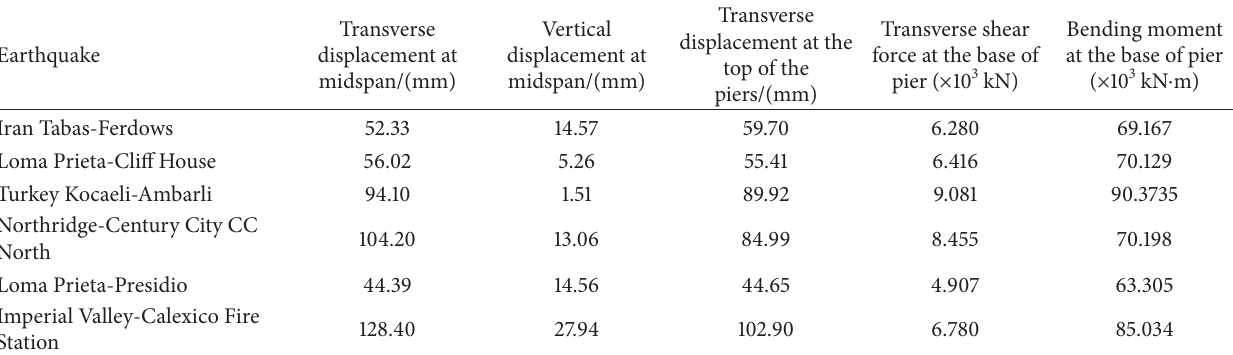
Table 10: Seismic response of high-speed railway bridge with 350 km/h vehicle speed and pier height 14m under high-level far-fault earthquake